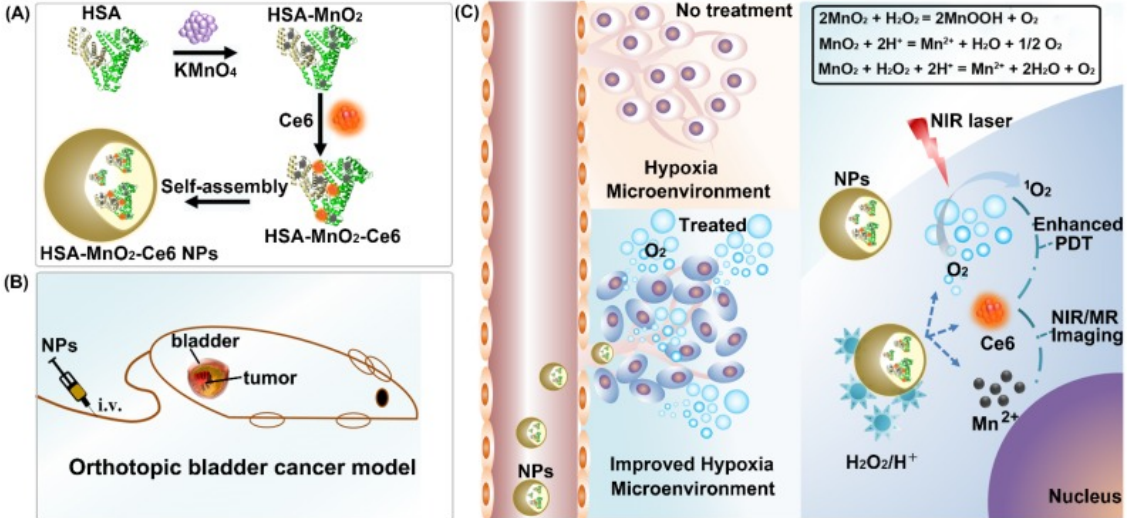
Figure 4. Scheme representing the production of oxygen from H 2 O 2 under laser irradiation, thus relieving hypoxia in the TME. ( A ) Formation of the nanocomplex, ( B ) intravenous injection of the nanoformulation and ( C ) mechanism of nanoformulation action inside the cell following combination therapy wherein Ce6 increases the efficiency of PDT and helps in imaging, Mn 2+ increases ROS production, and oxygen is generated via reaction between intracellular H 2 O 2 and hydrogen. Reproduced from Wu et al. [60] which is licensed under a Creative Commons Attribution-(CC BY 4.0) International License (http://creativecommons.org/licenses/by/4.0/).